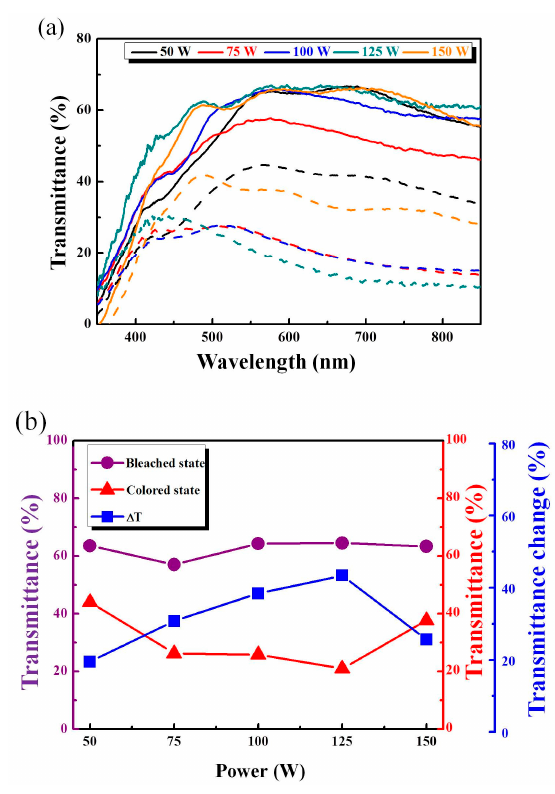
Figure 9. ( a ) The bleaching (solid line) and coloration (dotted line) state transmittance, and ( b ) bleaching, coloration, and Δ T = (T bleaching − T coloration ) of WO 3 /IZTO/ITO films at different sputtering powers.